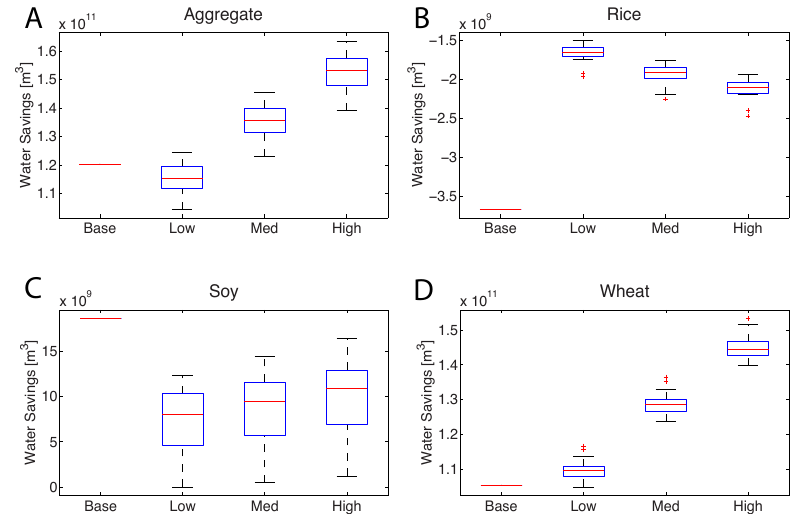
Fig. 6. GWS by commodity trade and yield scenario. ( a ) GWS associated with the trade of rice, soy, and wheat commodities; ( b ) GWS associated with the rice commodity trade only; ( c ) GWS associated with the soy commodity trade only; and ( d ) GWS associated with the wheat commodity trade only. Definitions follow Fig. Figure 6: Global water savings ( GWS ) by commodity trade and yield scenario. A) GWS associated with the trade of rice, soy, and wheat commodities; B) GWS associated with the rice commodity trade only; C) GWS associated with the soy commodity trade only; and D) GWS associated with the wheat commodity trade only. Definitions follow Fig 5.